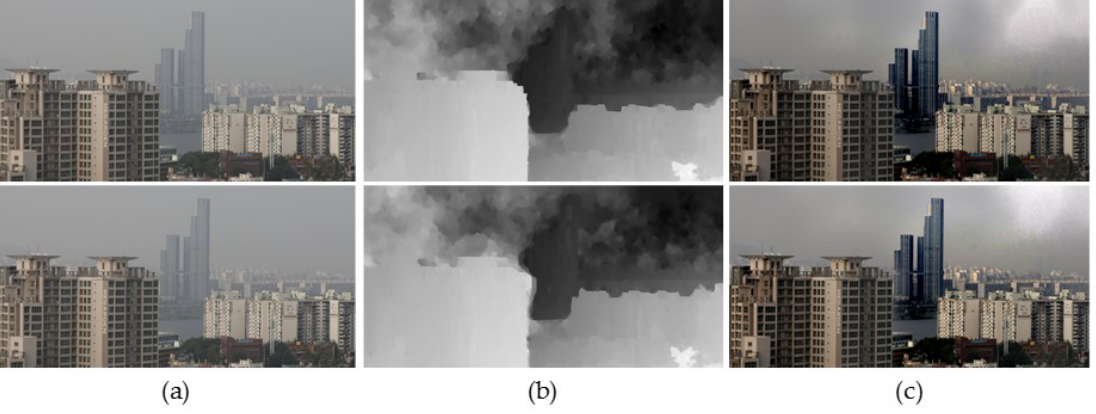
Figure 3. Results of defogging using the initial transmission map. ( a ) A stereo pair of input foggy images; ( b ) initial transmission maps; and ( c ) defogged